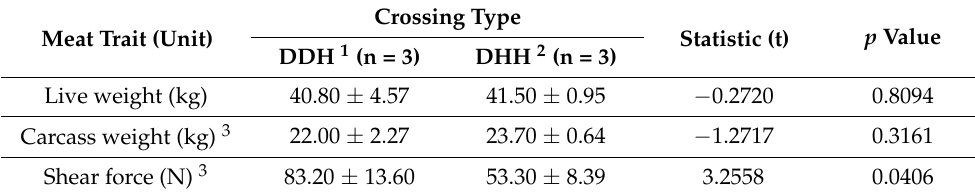
Table 1. Meat traits of Dorper × Hu × Hu (DHH) and Dorper × Dorper × Hu (DDH) sheep. Crossing Type Meat Trait (Unit) Statistic